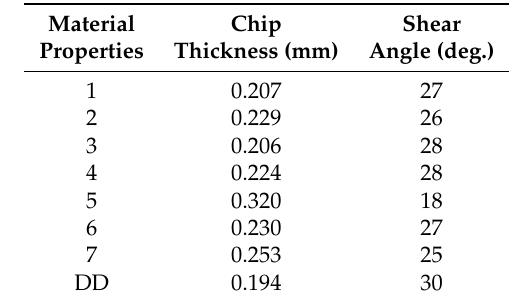
Table 8. Predicted chip thickness and shear angle at 60 m/min and a feed of 0.15 mm (Experiment 4). DD is an abbreviation for dislocation